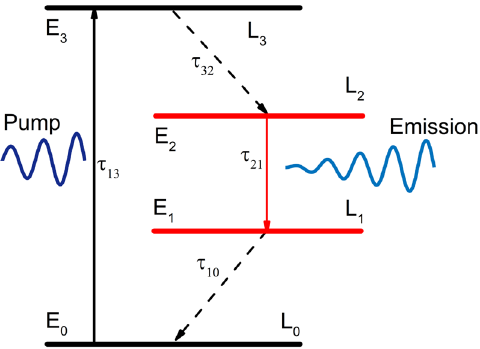
= 30 to L , the excitation quickly decay 3 0 to L . 2 1